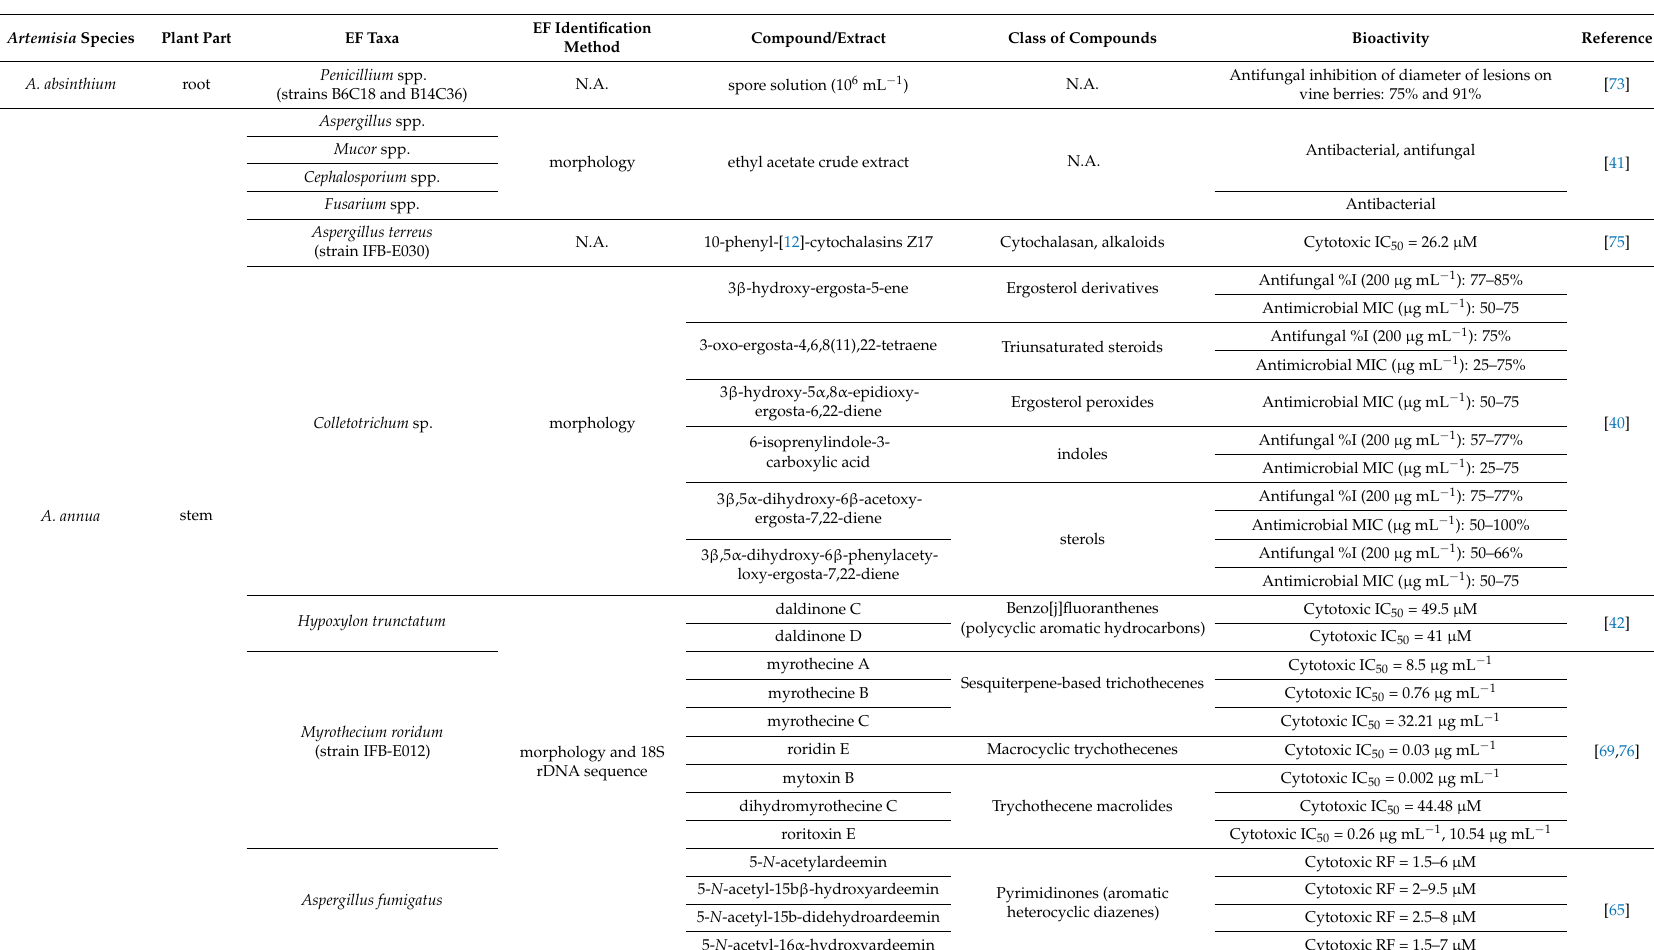
Table 2. Literature review on bioactive endophytic fungi (EF) isolated from species of Artemisia : host species, plant part of isolation, fungal taxa, endophyte isolation method, bioactive compounds/extracts, class of compounds, bioactivity, and